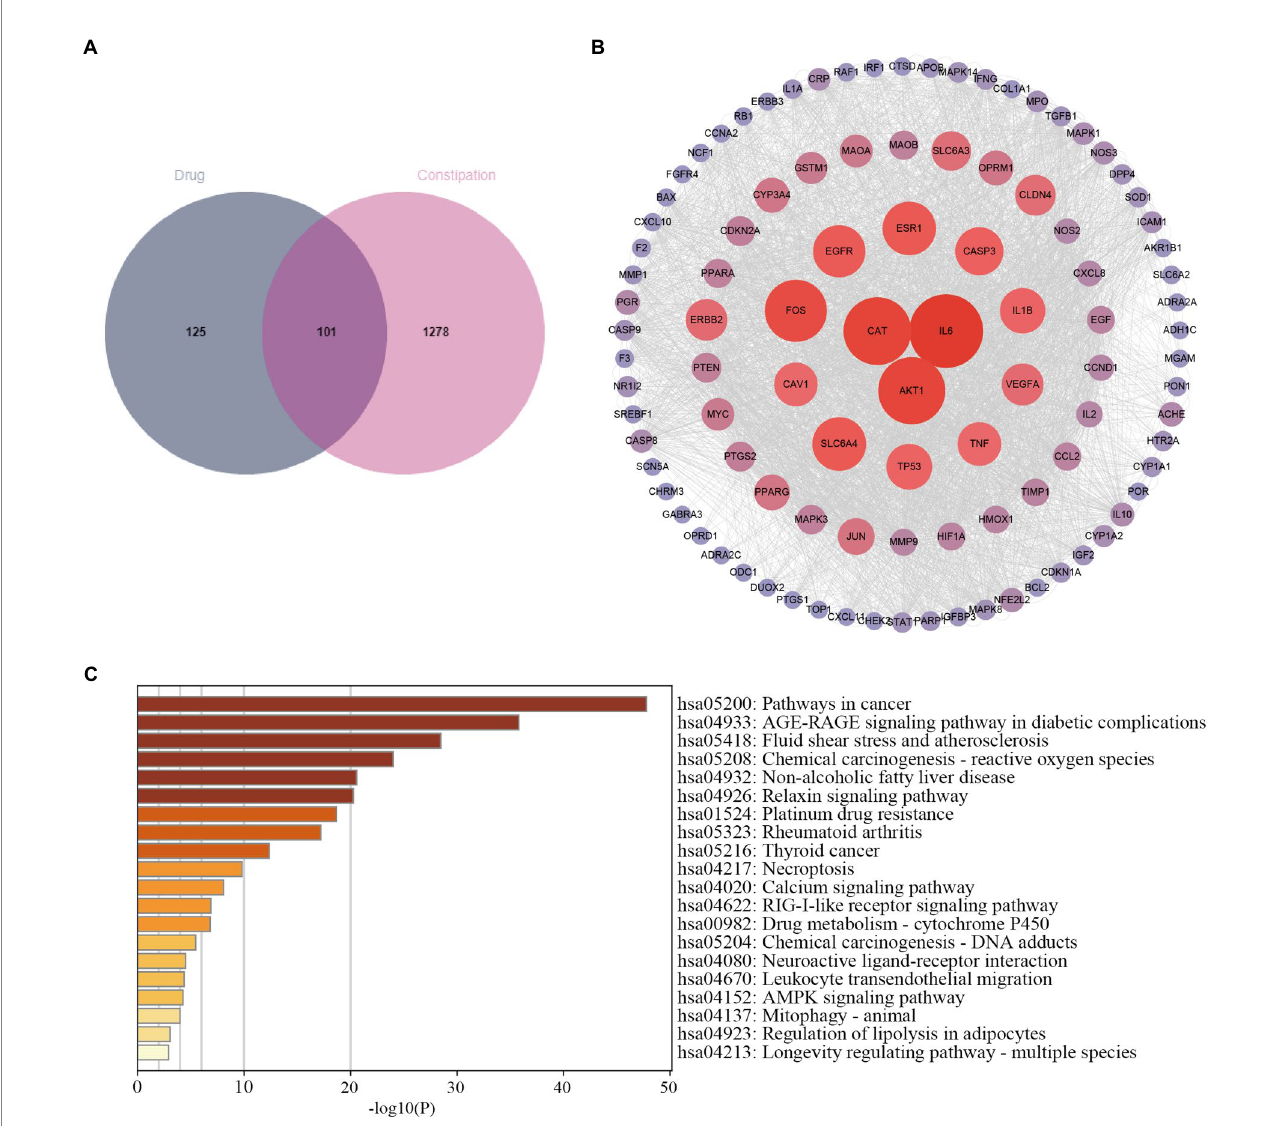
FIGURE 1 Pharmacological analysis of the network of SMD-constipation. (A) Venn diagram of the active ingredients of SMD and constipation. (B) Correlation network of SMD-constipation. (C) KEGG enrichment